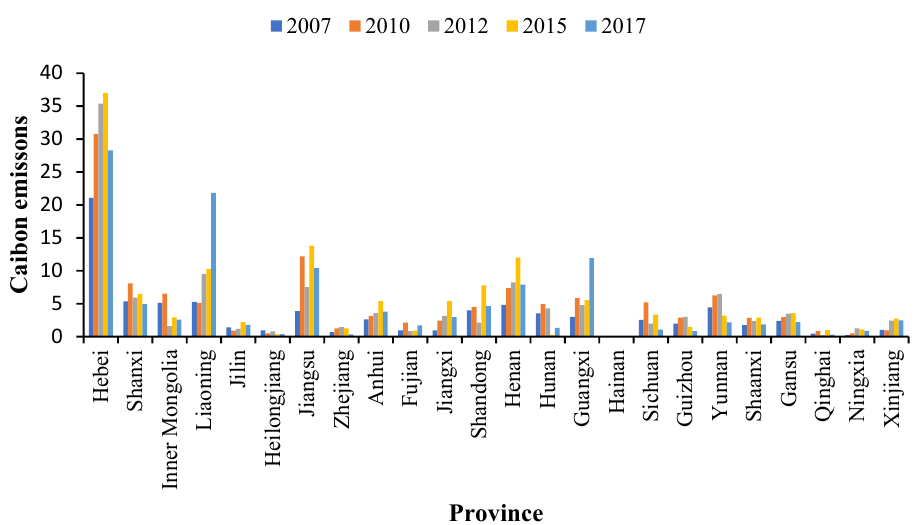
Figure 8. Increase in carbon transfer from pilot areas to non-pilot areas from 2012–2017 (unit: MtCO 2 ). From left to right and from top to bottom: the increase in non-pilot carbon transfer from pilot areas in the chemical, building materials, and metal industries from 2012–2017. Carbon leakage may occur not only between pilot areas and non-pilot areas but also between pilot areas due to different degrees of easing in terms of policy implementations (such as different carbon prices and punishment mechanisms, among others). Figure 9 shows the transfer in and out flows of carbon emissions between pilot areas in the chem- ical, building materials, and metal industries in 2012, 2015, and 2017. Compared with the other pilot areas, Hubei Province was a major carbon-emitting province. Whether in the chemical, building material, or metal industries, Hubei Province had the highest carbon emissions; it produced the most carbon emissions to meet its final needs. Among them,